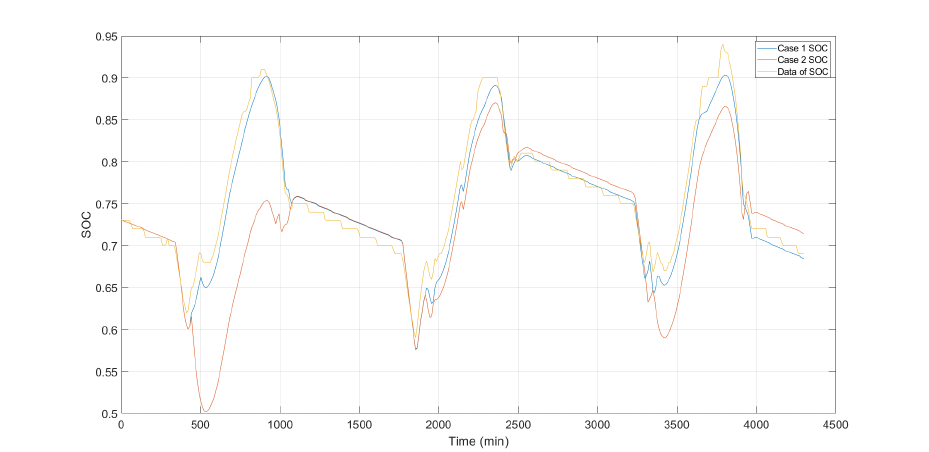
Figure 11. Batteries’ SOC evolution. SOC’s evolution case 1 (blue), SOC’s evolution case 2 (orange), and experimental data of the batteries’ SOC (yellow).